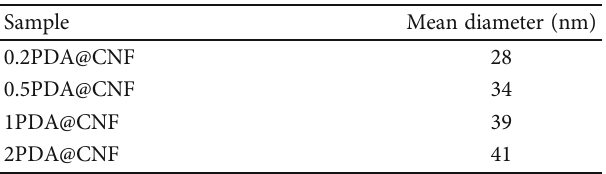
Figure 2: (a) Photo of DDT-0.5PDA@CNF aerogel, (b) and (c) SEM images of DDT-0.5PDA@CNF, (d) and (e) EDS and S element mapping image of DDT-0.5PDA@CNF, and (f) WCA of composite aerogels with di ff erent DA concentration. Table 1: The mean diameter of di ff erent PDA@CNF composite sca ff olds.